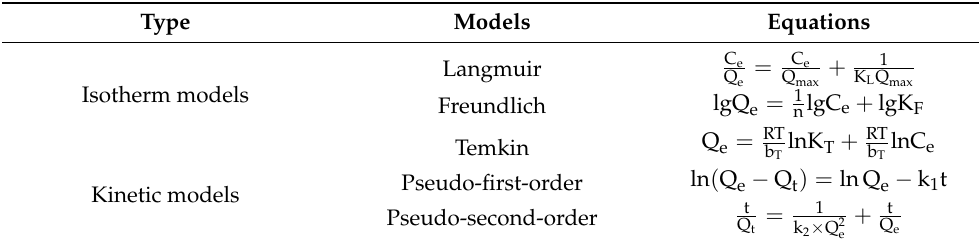
Table 1. Adsorption isotherm and kinetic models used in this